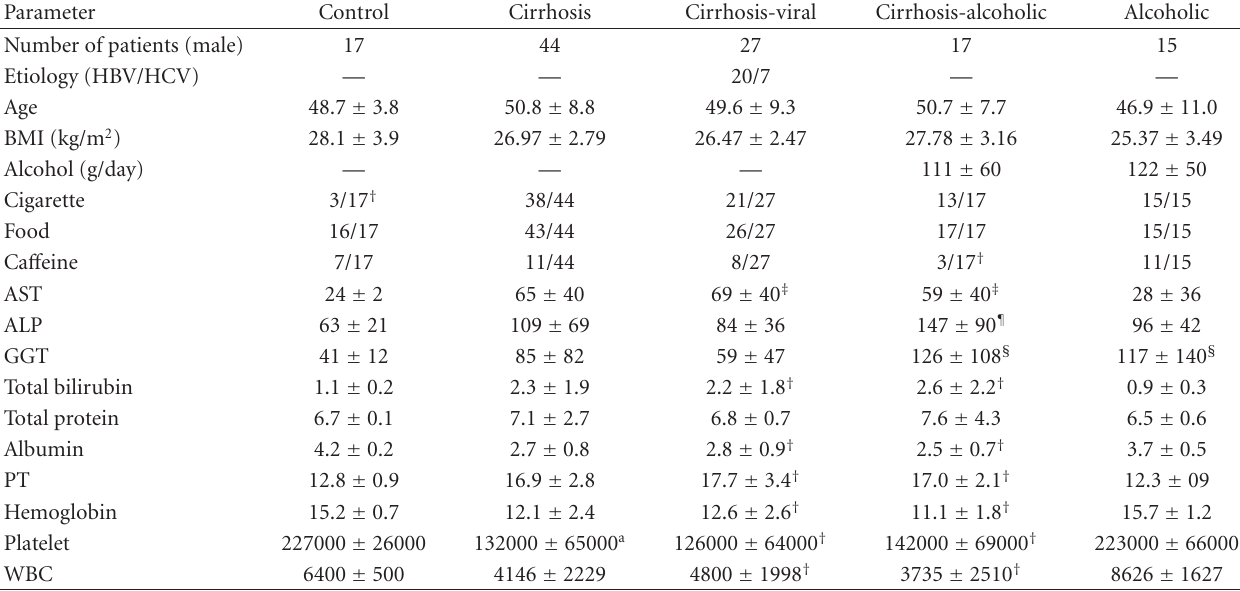
Table 1: Basic demographic and laboratory data ∗ of the study population.